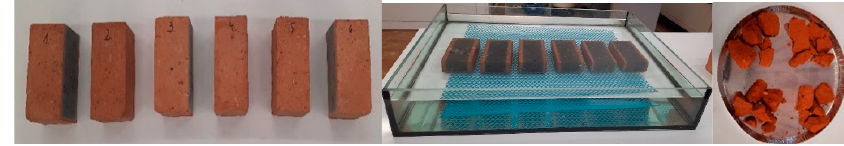
Figure 2. Preparation of samples for testing.